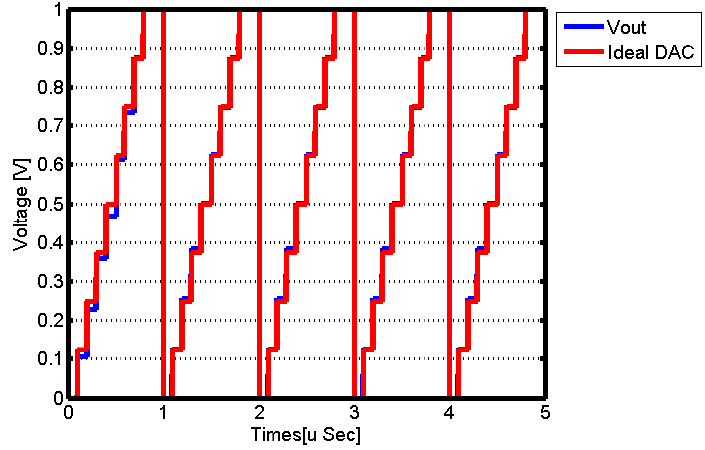
Figure 10. Simulation of an eight level input memristor-based DAC circuit.